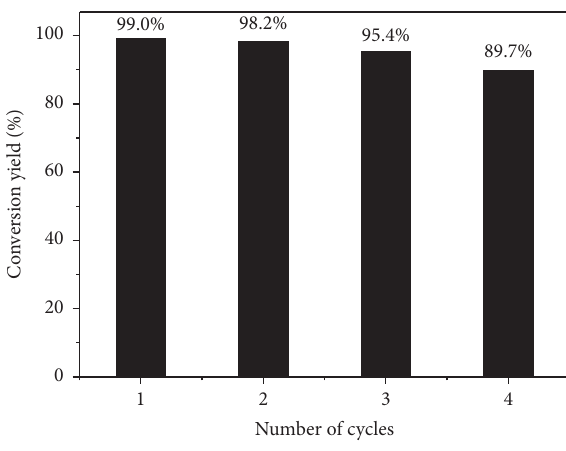
Figure 13: Reusability test of 2 wt% BiVO